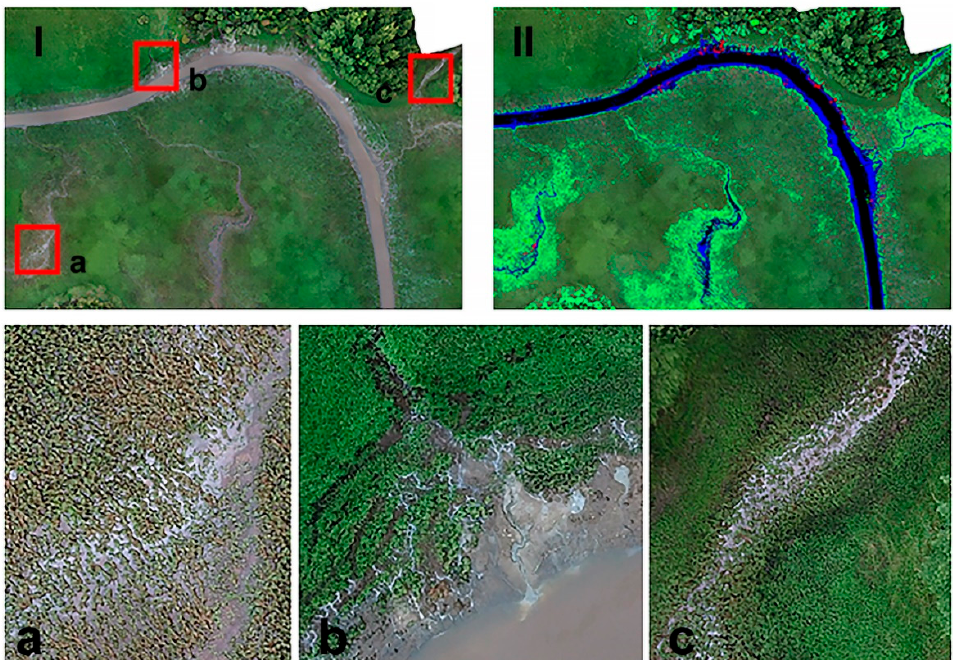
Figure 6. Mapping seep areas within the Big River site using UAV images: ( I ) the main channel with surrounding depressions, ( II ) RF classification of seep area: red—seeps, blue—seep abundance areas, green—seep-affected areas with no visible seeps, black—open water, ( a – c ) seep abundance areas are visible in the central parts, while vegetation obscures surrounding seep-affected areas (green).